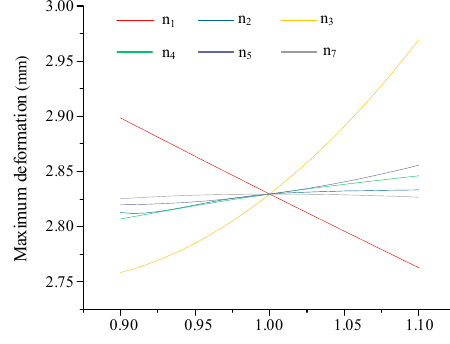
Figure 27. Deformation response curve.